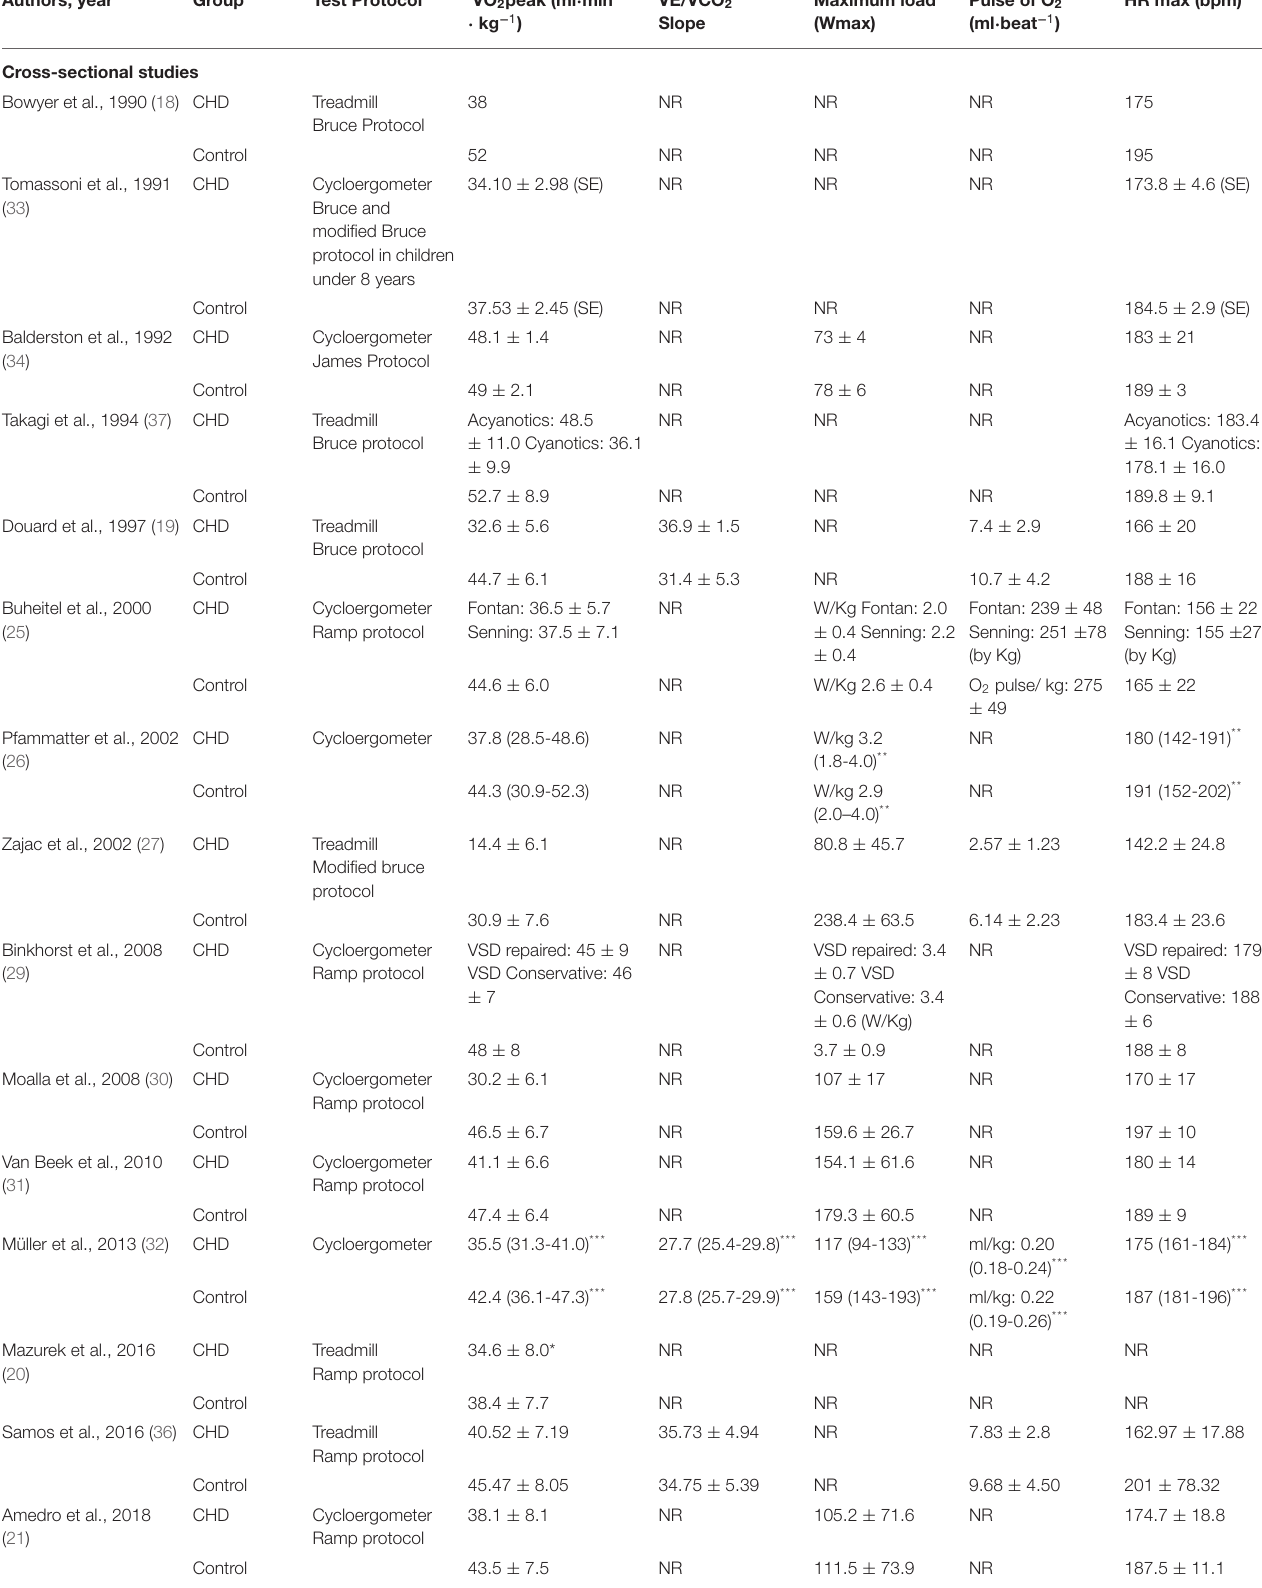
TABLE 2 | Results of the Cardiopulmonary Test of the included